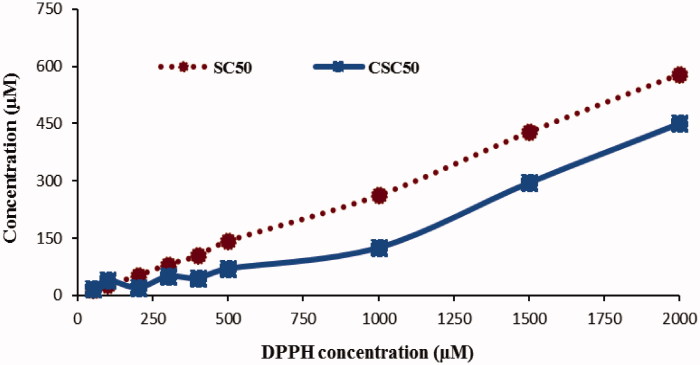
Linearity of SC50 and CSC50 values as a function of DPPH• radical concentration using Trolox standard.